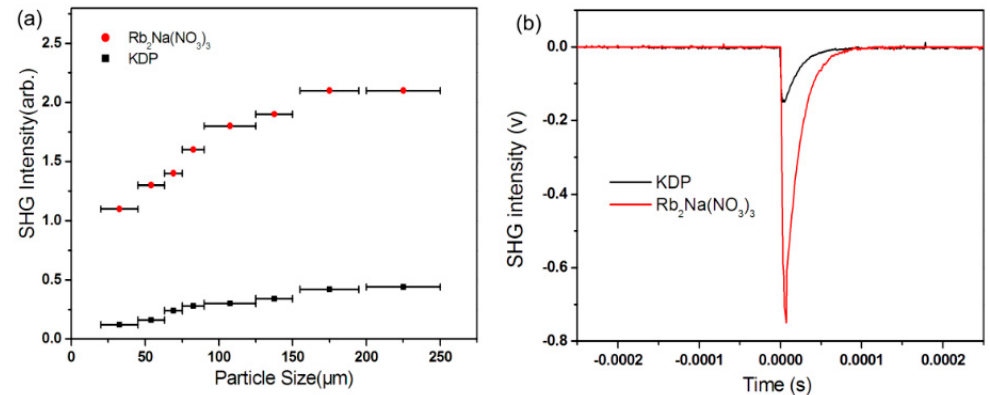
Figure 4. ( a ) Second-harmonic generation (SHG) intensity vs. particle size curves for Rb 2 Na(NO 3 ) 3 and KH 2 PO 4 (KDP) on a 1064 nm Q-switched Nd:YAG laser and ( b ) oscilloscope traces of the SHG signals